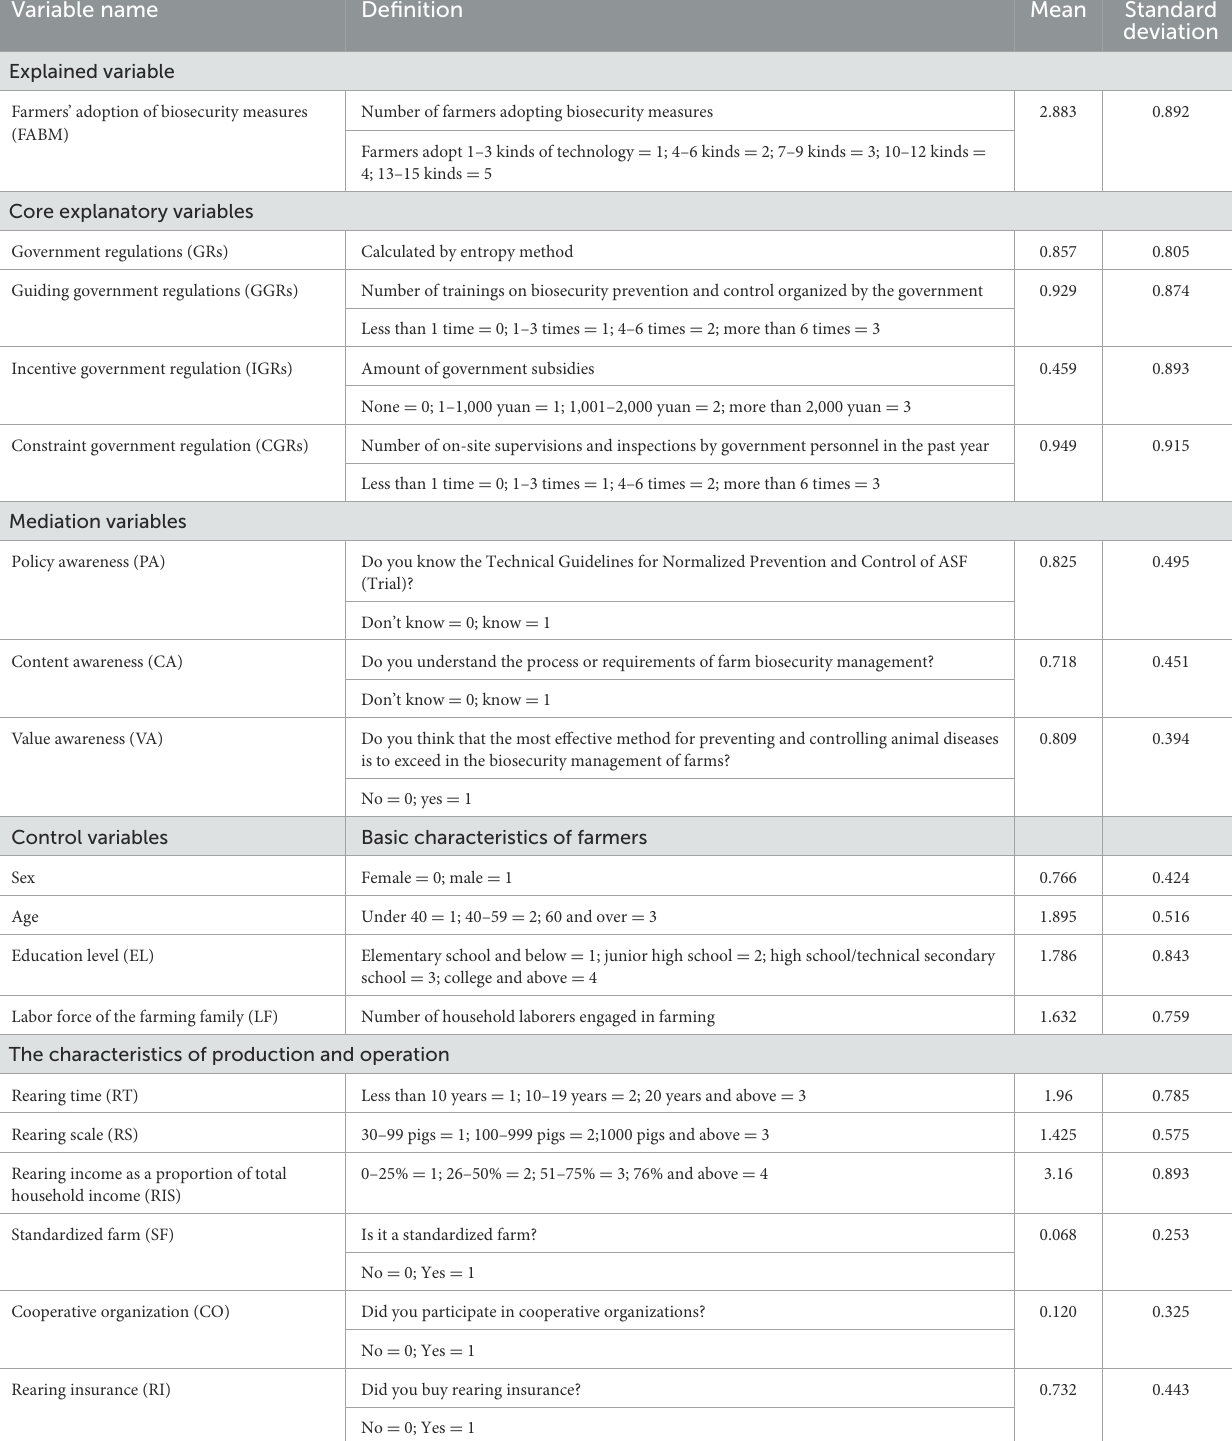
TABLE 2 Descriptive statistical characteristics of